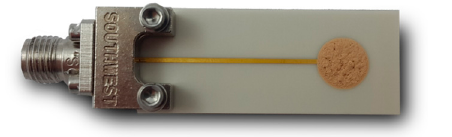
Figure 2. Final sensor device for measuring the reflection parameter S 11